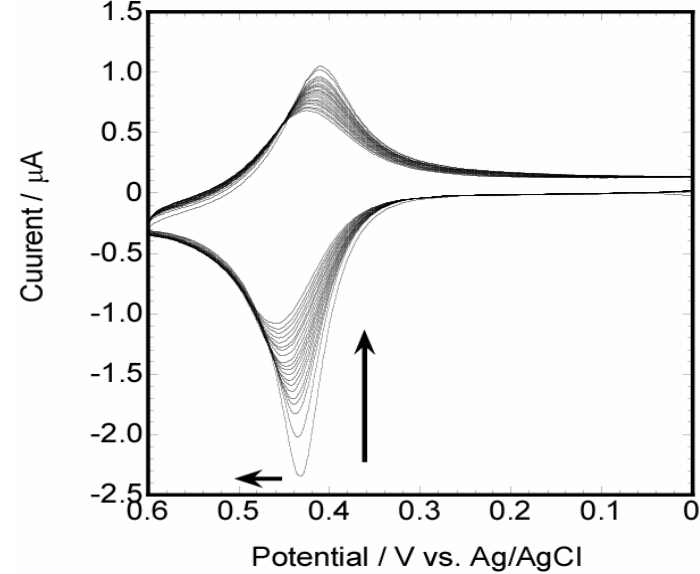
Cyclic voltammograms of a dA AcOK-AcOH buffer (pH 5.6) containing 0.1 M KCl and 0.05 mM 1 in the presence of 0-0.54 mM β